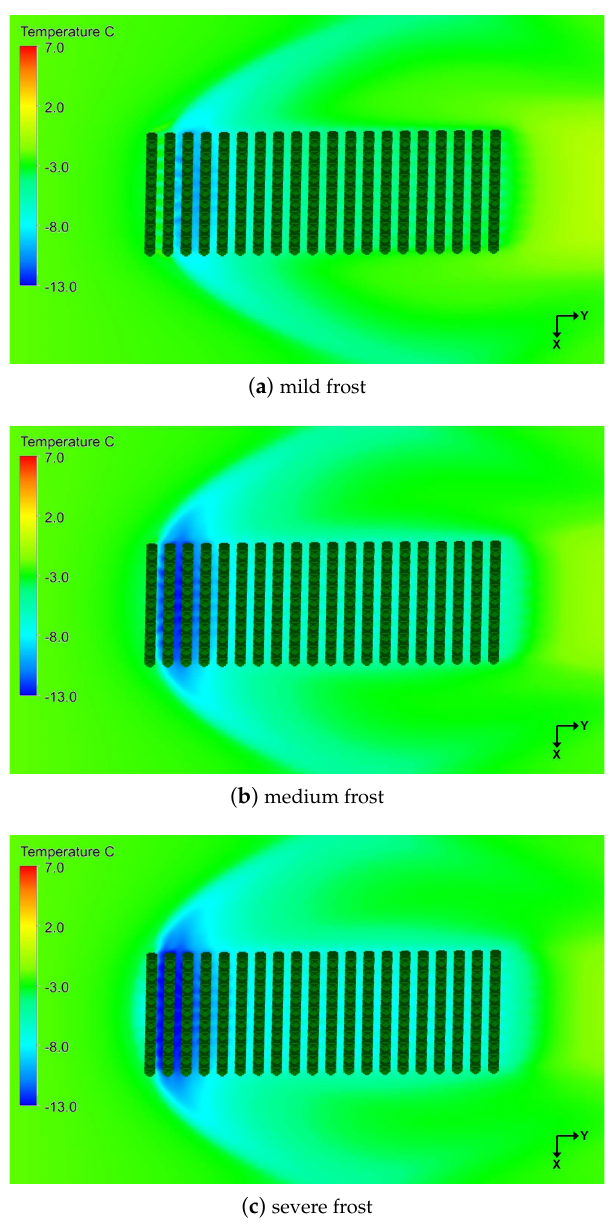
Figure 5. Horizontal temperature variation contours (uncontrolled case) for the considered frost episodes at a height of 1.5